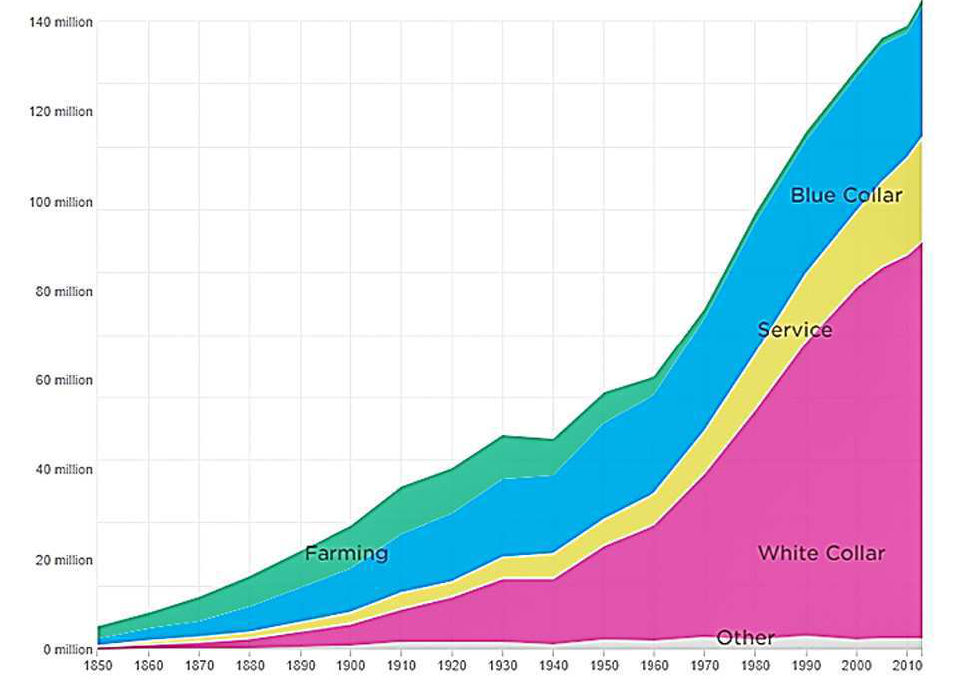
Figure 1. Demand for occupations in 1850–2010,